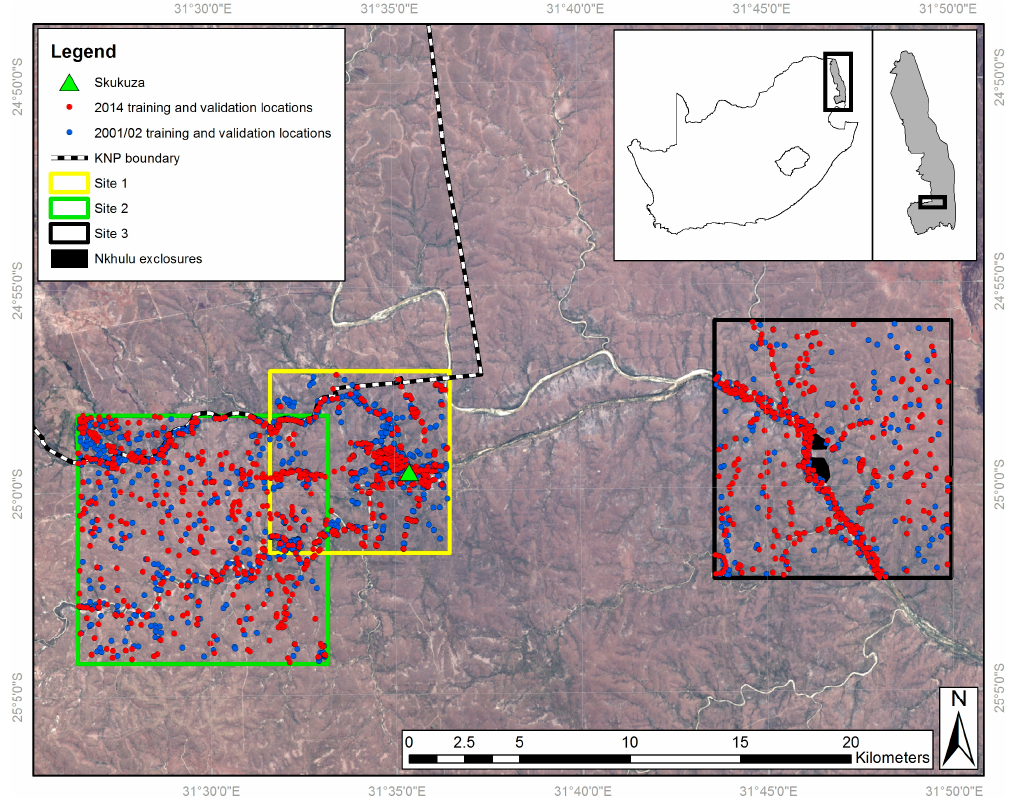
Figure 1. Study site locations overlaid on a 2014 Landsat Operational Land Imager image. Inset maps show the location of the KNP within South Africa, and the location of the study area within the KNP.